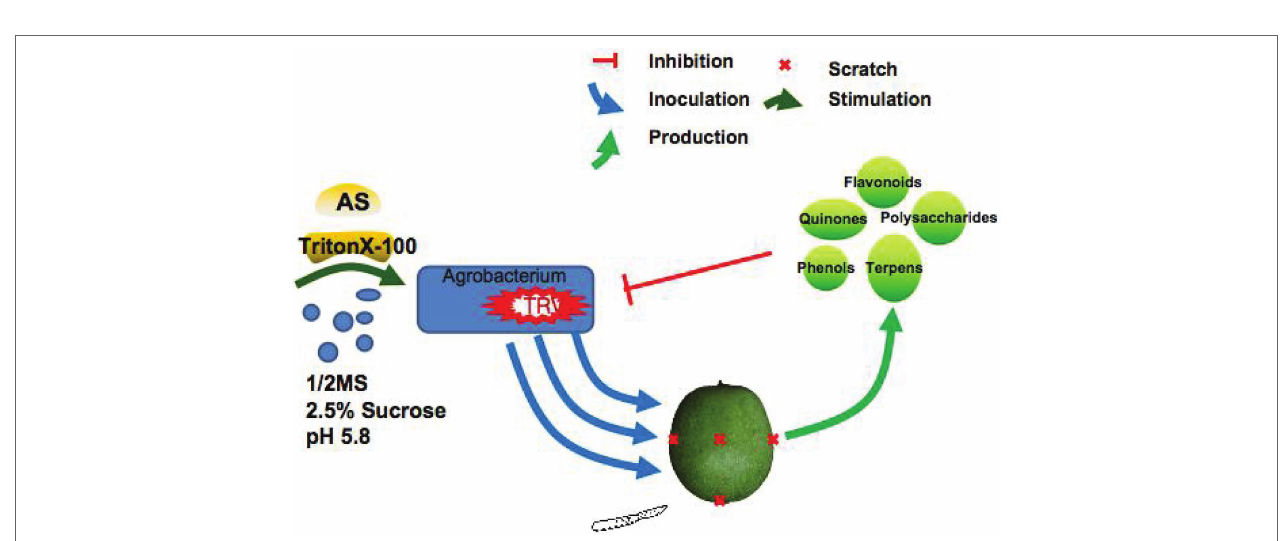
FIGURE 3 | “Qingxiang” fruits were not peeled before inoculation, and their phenotypes at each sampling day were shown in both unpeeled and peeled states. (B,C) The significantly reduced JrPDS expression levels in silenced fruits relative to the Mock and pTRV-00. Data were pooled across experiments and analyzed using Student’s t -test. Values were expressed as means ± SD. The asterisks indicate statistically significant differences compared with the control at * p ≤ 0.05 and ** p ≤ 0.01. (D) RT-PCR detecting low JrPDS expression in pTRV- JrPDS -infected fruits. (E) Microscopic observation on pTRV-00 and pTRV -JrPDS -silencing fruits at 8 dpi. Scale bar = 100 μ m. (F) The significantly decreased photosynthetic pigments in JrPDS -silenced fruits, compared with pTRV-00-infected fruits. Each experiment was performed with three biological replicates, and samples were collected at 8 dpi. Values were expressed as means ± SD. Asterisks indicate a statistically significant difference compared with the pTRV-00 treatment (Student’s t -test; p < 0.01).